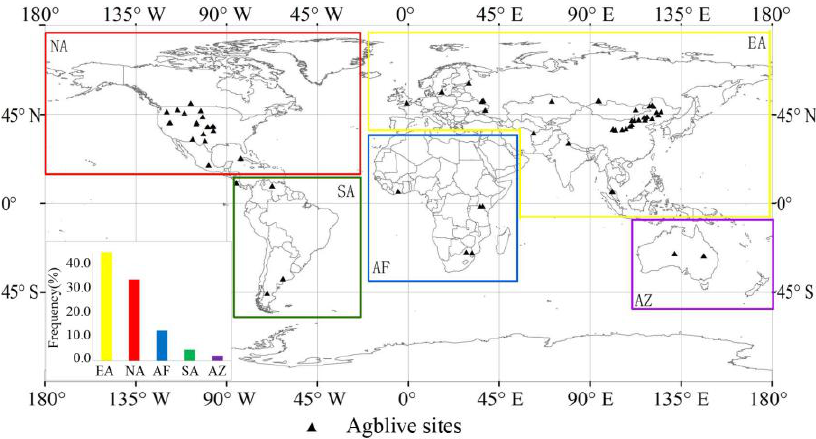
Figure 1. Map showing locations of the 81 field plots of aboveground live biomass (Agblive) measurements used for model calibration and validation. The inset shows the frequency distribution of field sites in the five